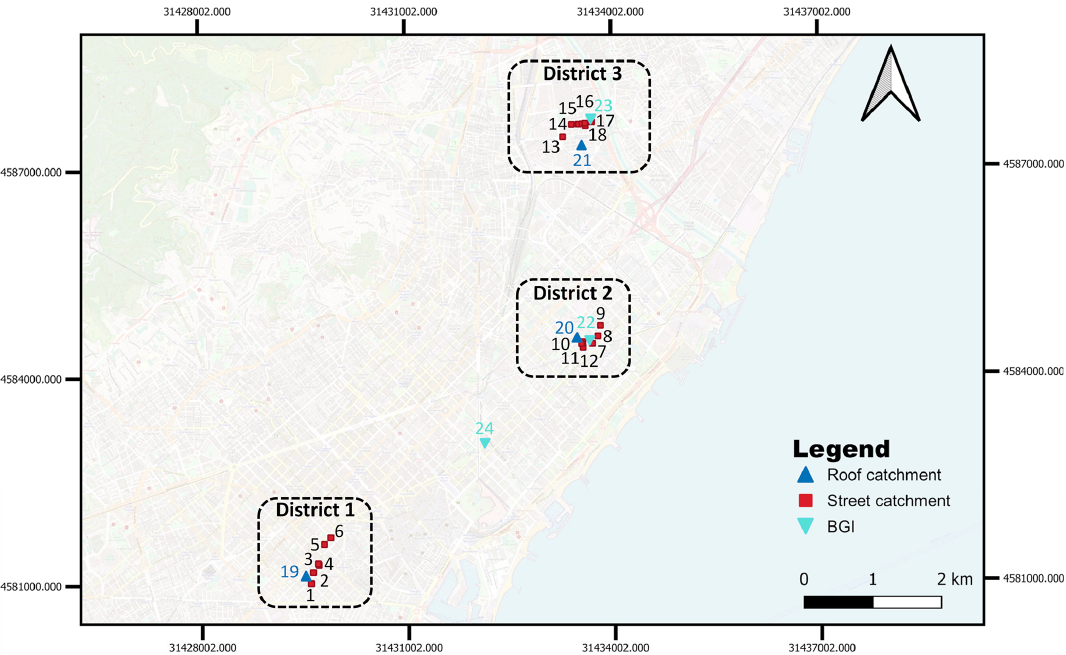
Figure 1. Location of the sampling sites located in three different Barcelona districts (Districts 1, 2 and 3 stand for “Eixample”, “St. Martí” and “St. Andreu”, respectively). Seven sampling campaigns were conducted during Spring 2022 in three different catchment areas: roof (dark blue triangles), street (red squares), and blue-green infrastructure effluent (light blue inverted triangles). The World Geodetic System (WGS84) was used as reference coordinate system. Source for basemap: © ArcGIS